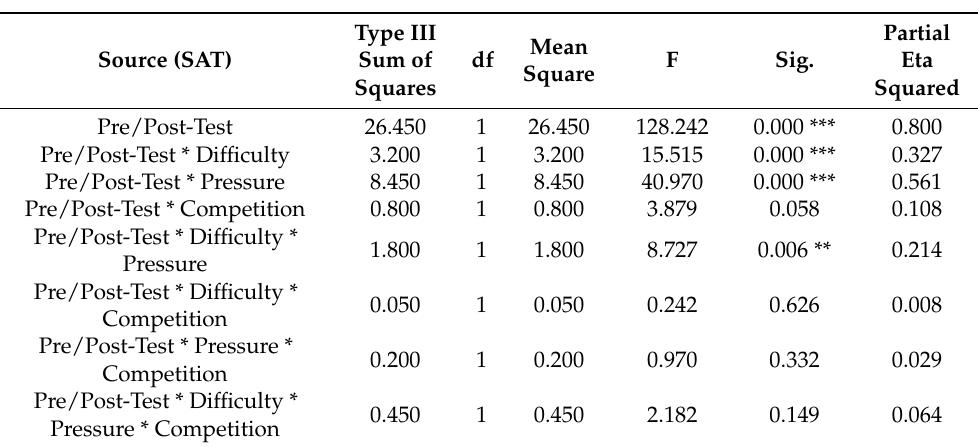
Table 11. Tests of within-subject effects of